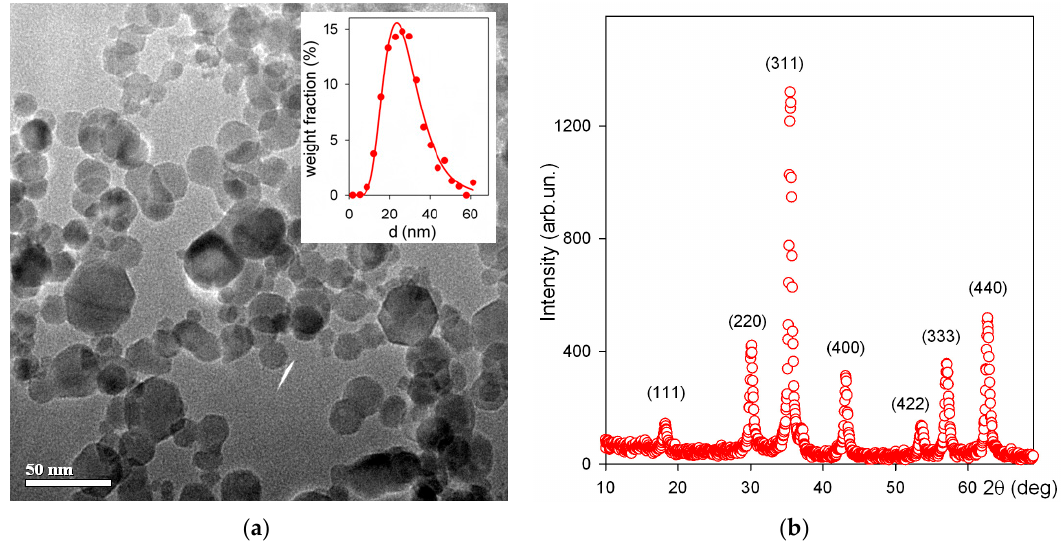
Figure 2. TEM image of iron oxide MNPs (JEOL JEM2100 operating at 200 kV). Inset: particle size distribution (number averaged) obtained by the graphical analysis of TEM images (2160 particles) ( a ). XRD plot for iron oxide MNPs (Bruker D8 DISCOVER) Cu-K α radiation ( λ = 1.5418 Å), a graphite monochromator and a scintillation detector ( b ).